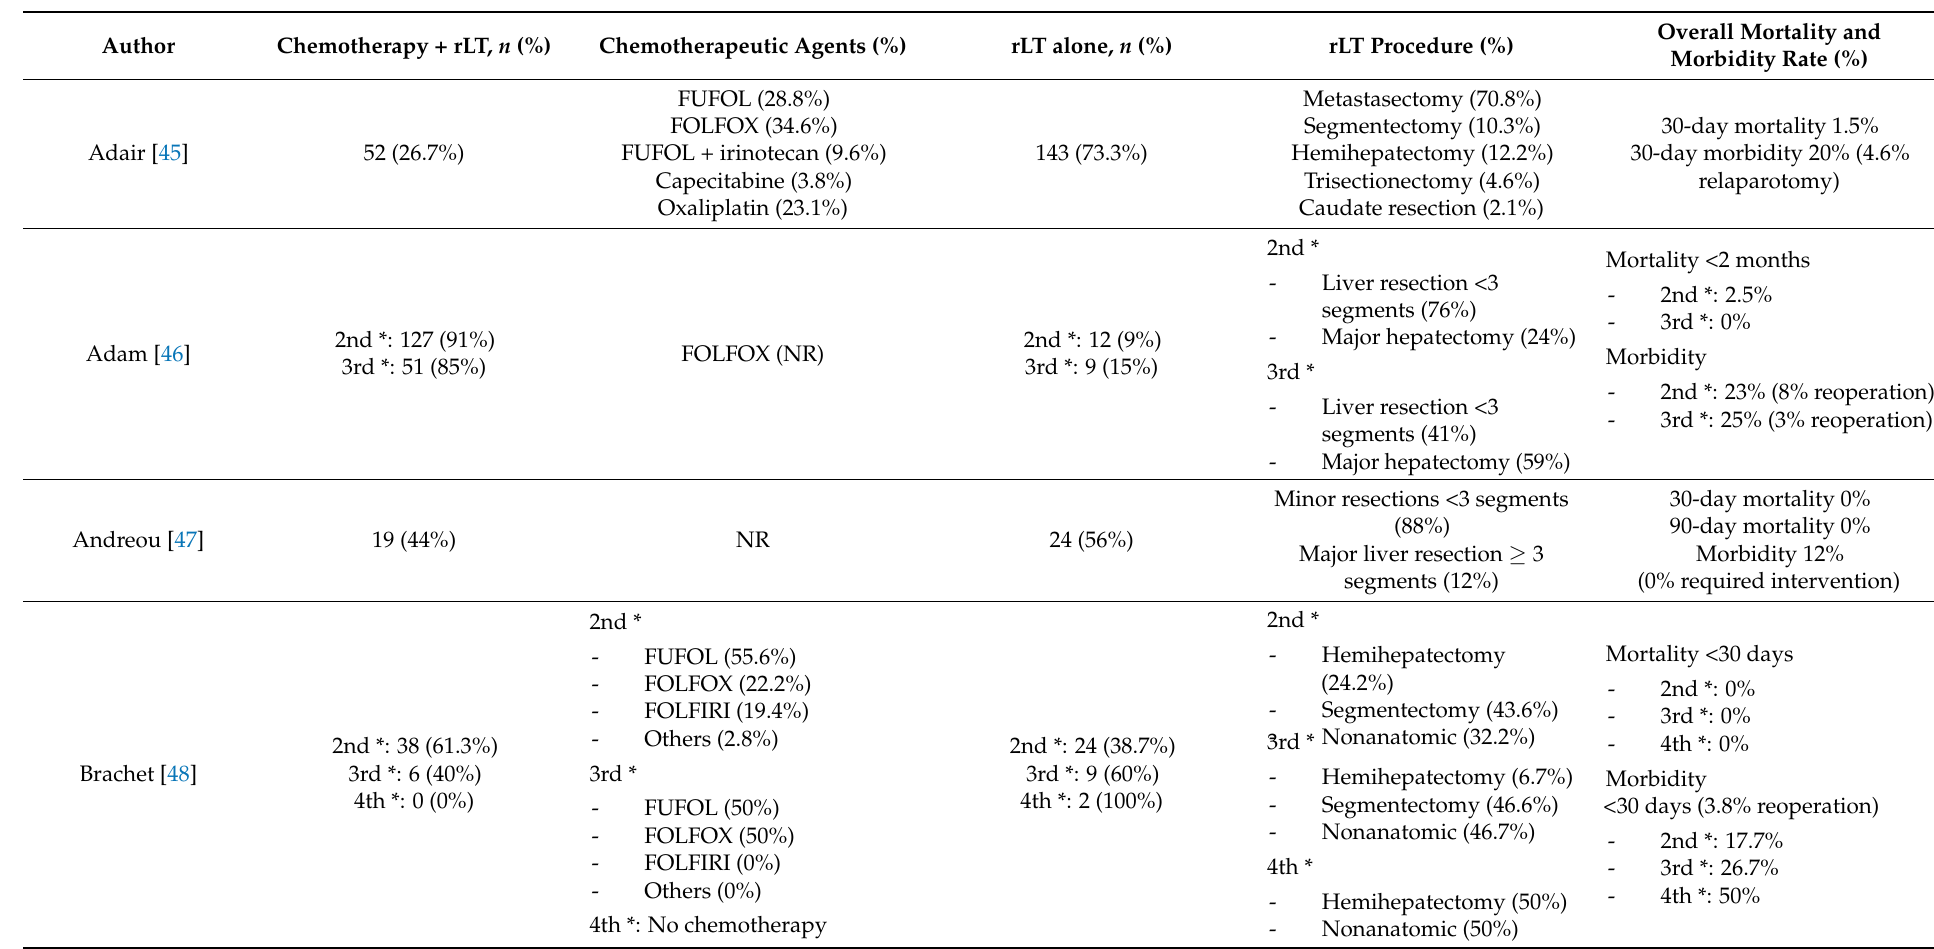
Table 2. Subgroups of treatment for recurrent CRLM, type of procedures, mortality, and morbidity